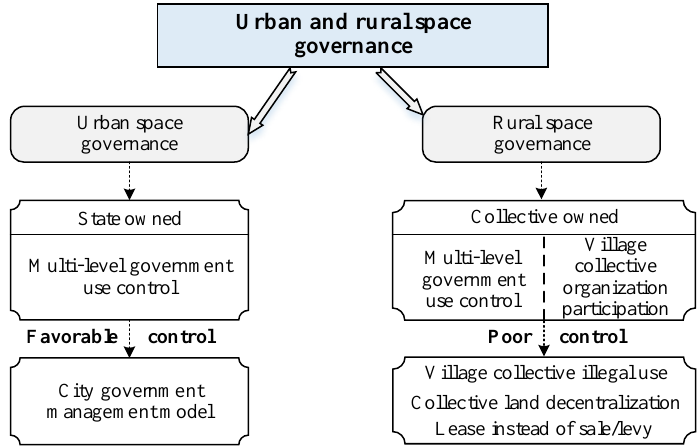
Figure 1. Different ownership of urban and rural spaces in China. The differentiation of multiple subjects and the unsound mechanism of interest game have become the organizational background factors hindering the renewal of rural indus- trial land. The vigorous development of rural industrial land in the rural areas of the Pearl River Delta continues to this day for reasons closely related to the village community formed by the bond of village clan relationships. There is a strong patriarchal concept that, superimposed on consistent economic interests, gives rise to a solid grassroots community of shared interests; grassroots village collective organizations with a stock of rural industrial land, a strong sense of rights and interests, and strong grassroots organizational capabilities; economic organizations such as land stock cooperatives, which further bolster the strength of the farmers’ organizations in the region [16,22]. Since China’s reform and opening up, in the process of pursuing economic development, the government’s ability to control grass- roots villages has weakened, and the space-use control policy has changed significantly. The notable feature is that the development of rural industrial land has changed from early encouragement to subsequent restrictions and then to the current guidance and renewal. A grassroots governance pattern of “weak government and strong society” has gradually formed. Local entrepreneurs and new foreign entrepreneur groups closely related to the development and leasing of rural industrial land are intertwined between the grassroots village collective organizations and multilevel governments, seeking to maximize bene- fits, thus making it normal for multiple entities to participate in the transformation and renewal of rural industrial land. In the face of the government’s implementation of the “Transformation of the Three Olds”, the “Double Compliance” (remediation measures for rural industrial parks to make environmental protection and safe production up to standards), and other rural industrial land renewal policies, the degree of differentiation of the interests of multiple subjects has further deepened (Figure 2). How to effectively promote the “top-down” linkage, fairness, and justice of the interests of multiple subjects has become a core